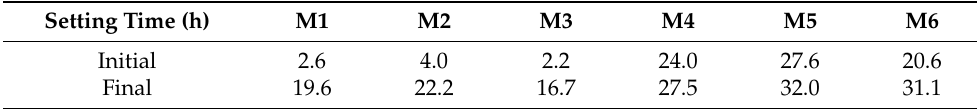
Figure 3. Variation in penetration of the needle along the curing time. Table 5. Setting times of the CLSM